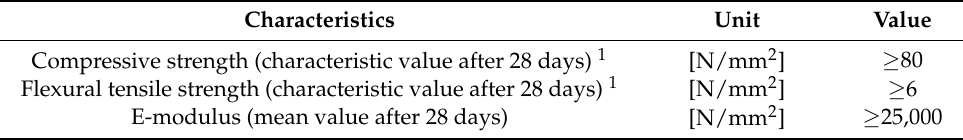
Table 1. Characteristics of the CARBOrefit ® fine-grained concrete, according to [30]. Characteristics Unit Value Compressive strength (characteristic value after 28 days) 1 [N/mm 2 ] ≥ 80 Flexural tensile strength (characteristic value after 28 days) 1 [N/mm 2 ] ≥ 6 E-modulus (mean value after 28 days) [N/mm 2 ] ≥